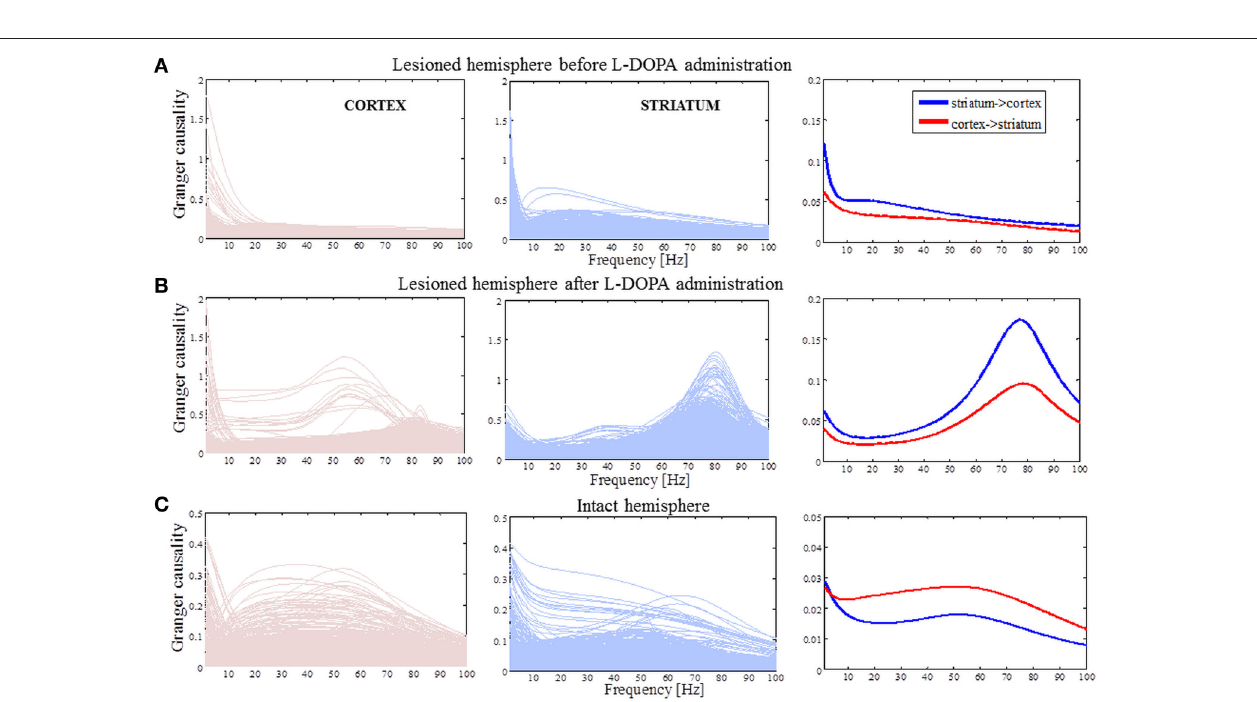
FIGURE 5 | Causality spectra analysis. (A) Granger causality for the lesioned hemisphere before levodopa administration. Left panel illustrates GC values when the cortex is assumed to be a source (driving striatal activity) and represents the traces for all pairs of the cortico-striatal electrodes. Middle panel shows GC values in the case where the striatum is assumed to be a source and the right panel shows averaged values. (B) The same analysis as in (A) for the lesioned hemisphere after levodopa administration. (C) Granger causality for the intact hemisphere before levodopa administration [the same analysis as in (A) ]. The y-axes are different in order to improve